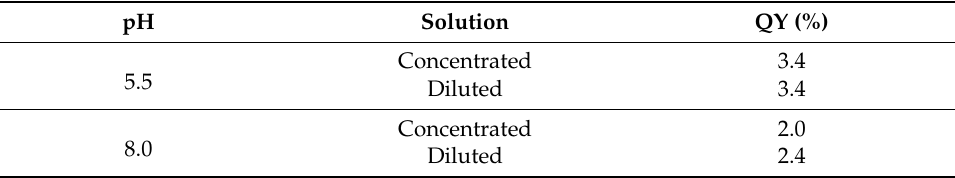
Table 4. The QY of dopamine at different pH values and concentrations calculated under 280 nm